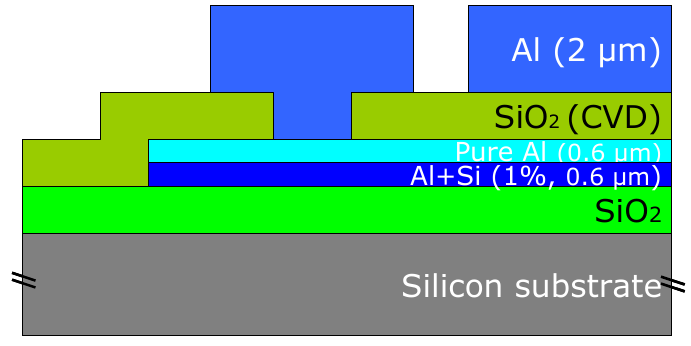
Figure 8. Cross section of the spiral inductors with two metal layers in CMOS